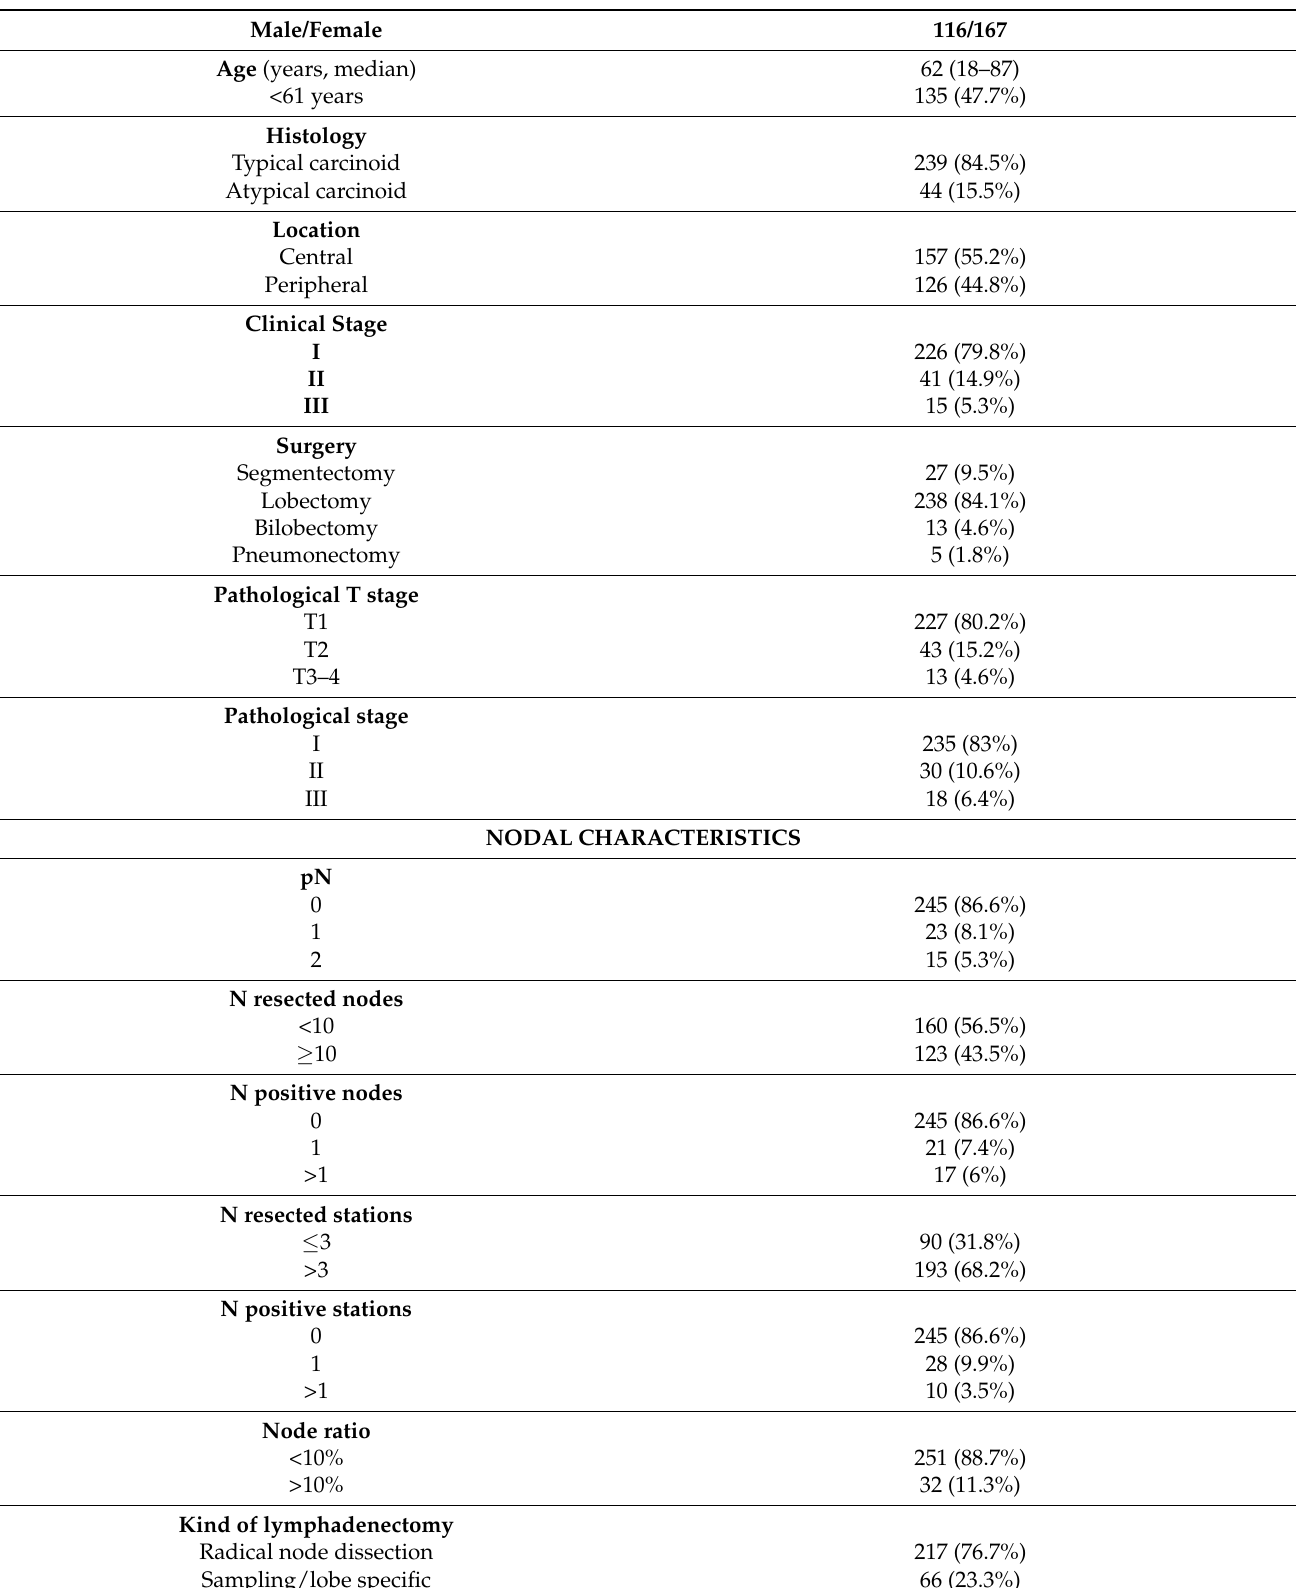
Table 2. Clinical and pathological